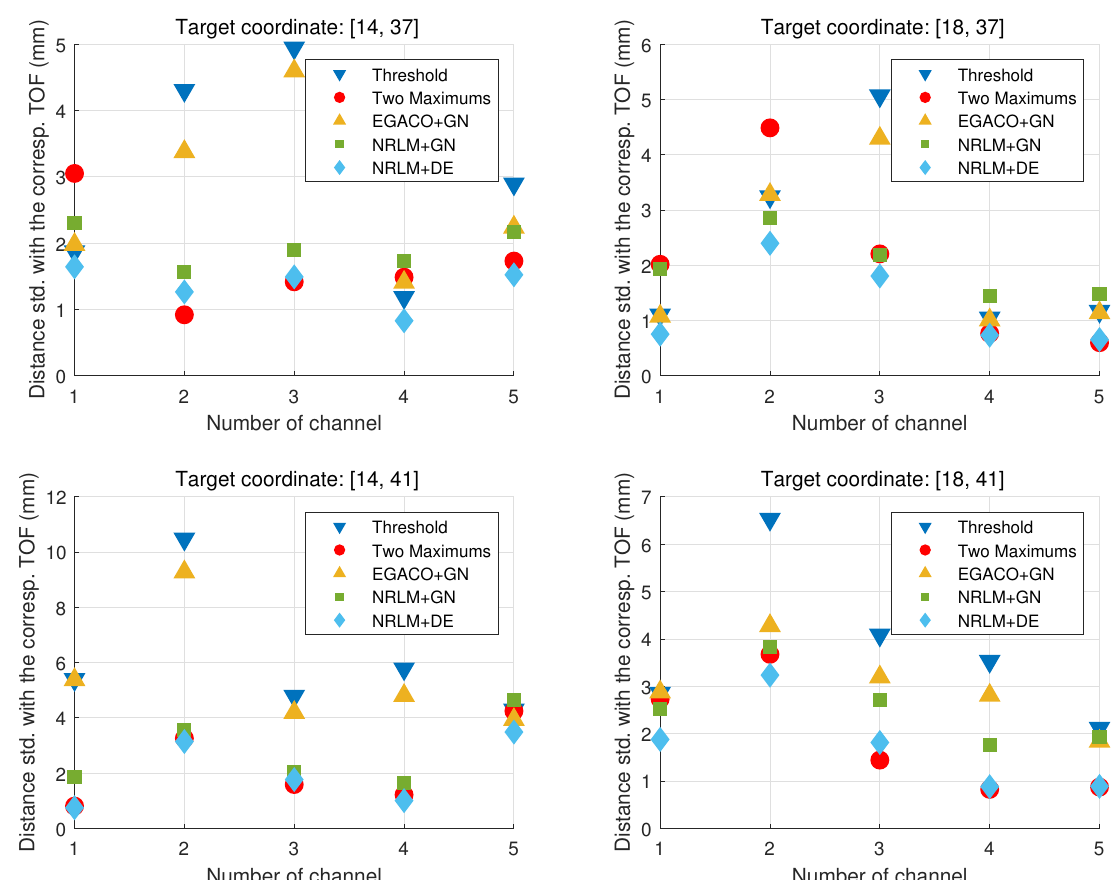
Figure 10. Case 2 (human index finger): Standard deviations of distances with the corresponding TOFs of different methods among five receiver channels. ( (cid:72) ): threshold method; ( • ): two-maximums algorithm; ( (cid:78) ): EGACO algorithm with GN model; ( (cid:110) ): NRLM algorithm with GN model; ( (cid:7) ): NRLM algorithm with DE model. (Vertical coordinate unit: mm).